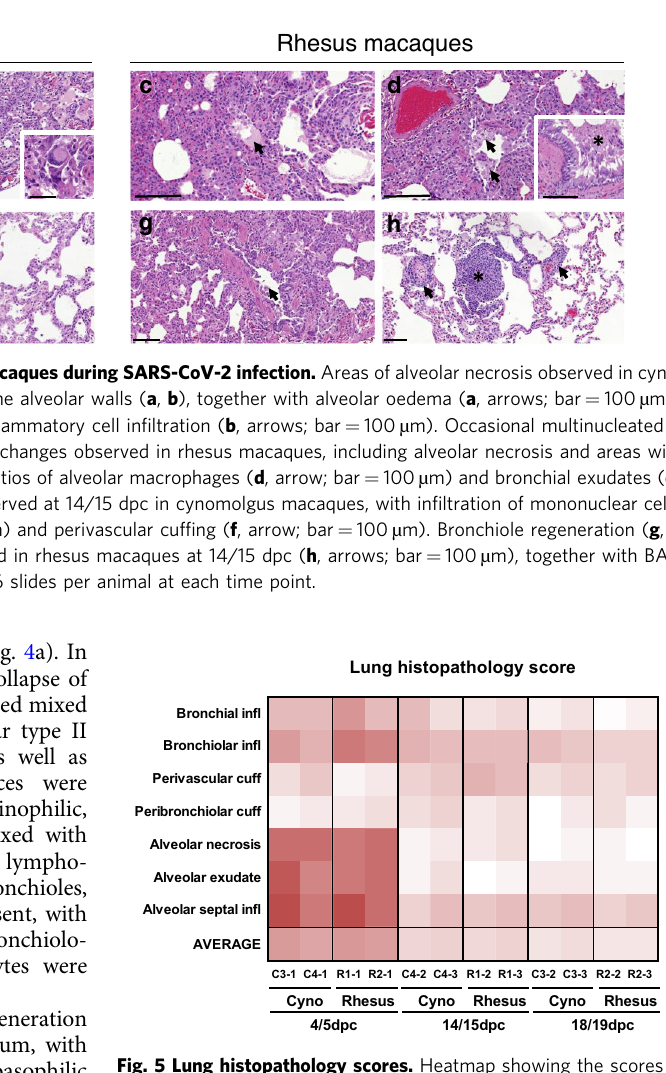
Fig. 5 Lung histopathology scores. Heatmap showing the scores for each lung pathology parameter and the average score for each animal culled at 4/5, 14/15 and 18/19 dpc. Severity ranges from 0 to 4: 0 = none; 1 = minimal; 2 = mild; 3 = moderate and 4 =